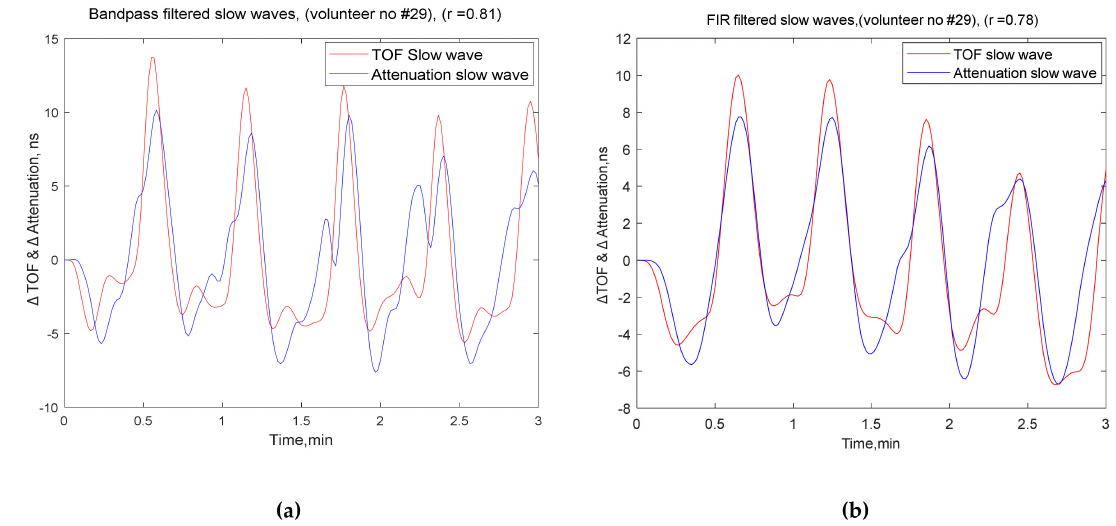
Figure 4. Examples of three minute periods of slow waves extracted from time-of-flight and attenuation dynamics; comparison of participants with ( a ) excellent correlation by the bandpass filter and ( b ) excellent correlation by the FIR filter.